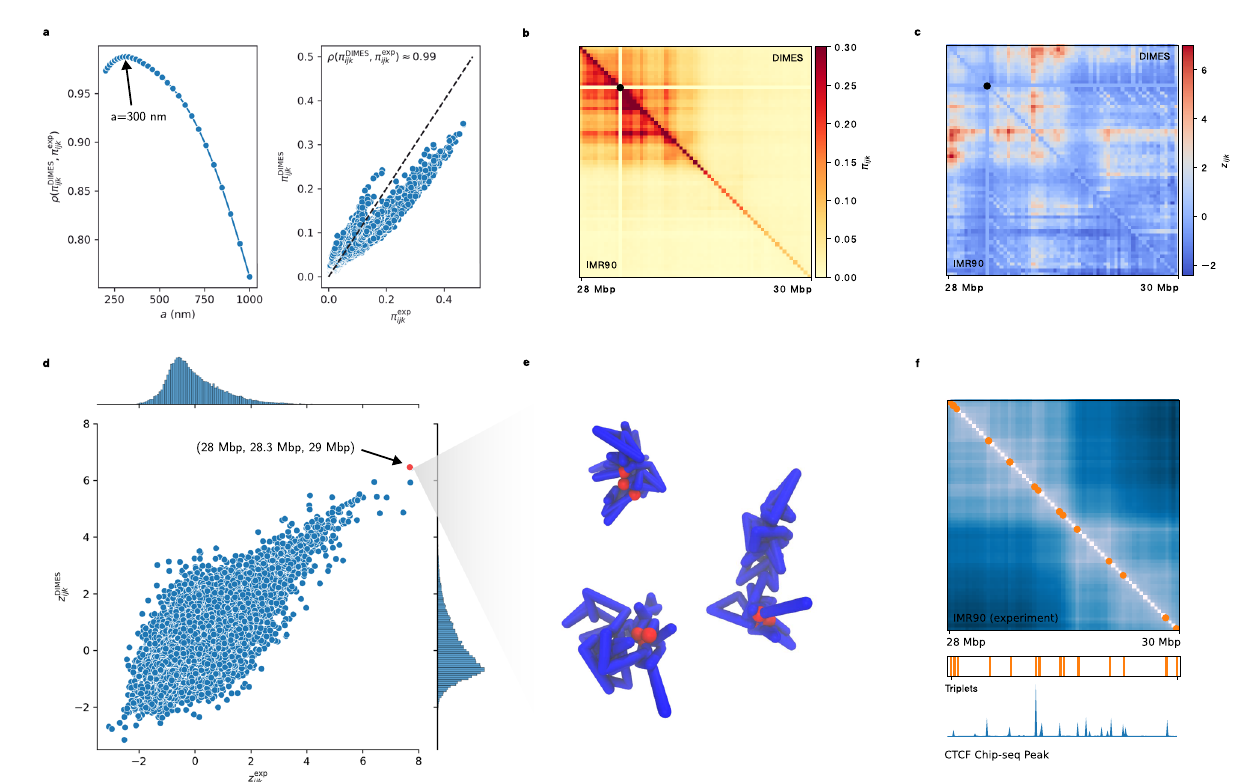
Fig. 3 | Comparison between the calculated and measured P ( r ij ). a The Jensen – Shannon divergence (JSD) matrix computed from experiments (top half) andusingDIMES(bottomhalf).ThescaleontherightshowsthatthemaximumJSD value is ≈ only 0.12, thus establishing the effectiveness of DIMES in calculating the